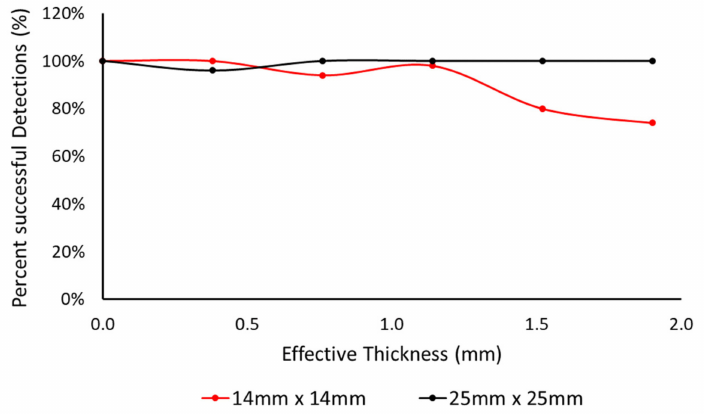
Figure 11. Performance of capacitive touch sensor setup in blocks of both 14 mm × 14 mm and 25 mm × 25 mm detector plates.